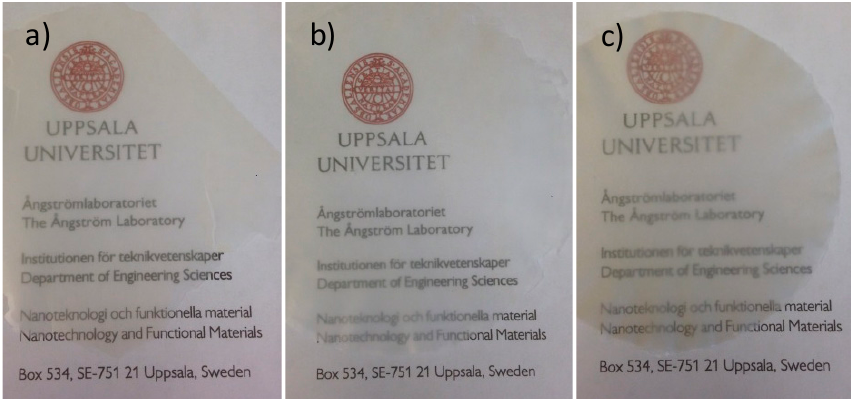
Figure 4. Photographs of translucent films of ( a ) pulp-O; ( b ) pulp-O-Br; and ( c ) pulp after 15 passes through the homogenizer. The films were photographed on top of a printed page to demonstrate their transparency.